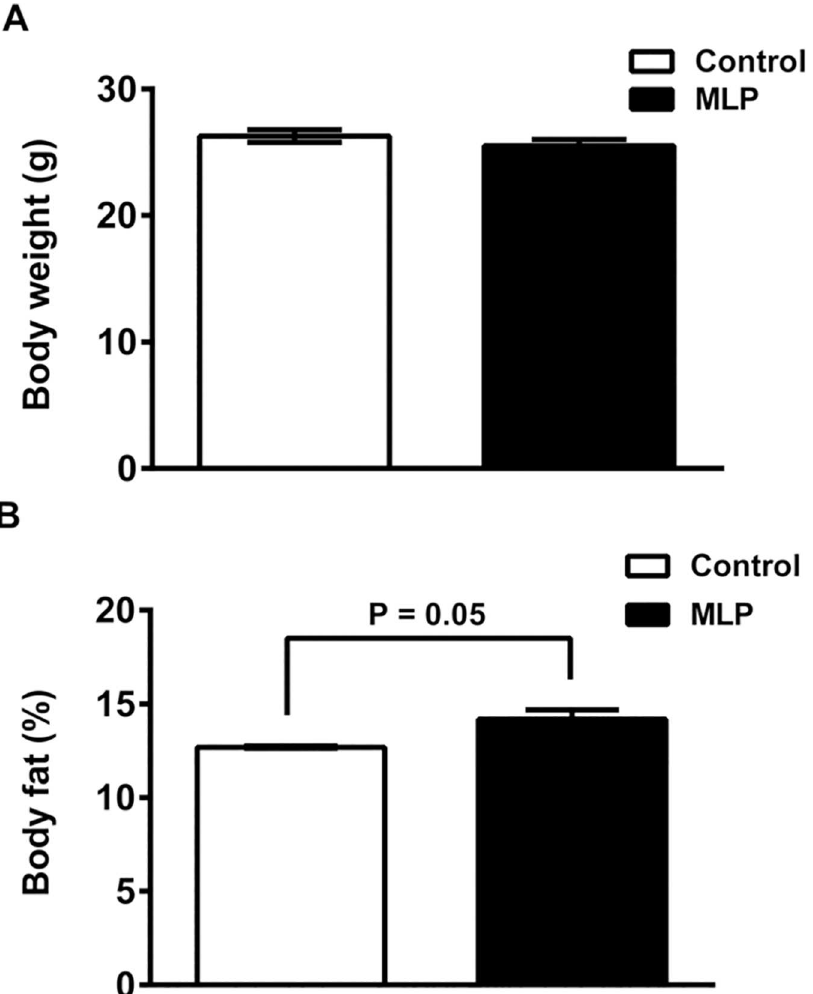
Fig 1. Body composition. (A): Body weight; (B) Body fat as percent of total body mass in male offspring (8–12 weeks age) from dams exposedto either control or MLP diet (n = 7 each). Bars are mean ± SEM and P < 0.05statistically significantby student